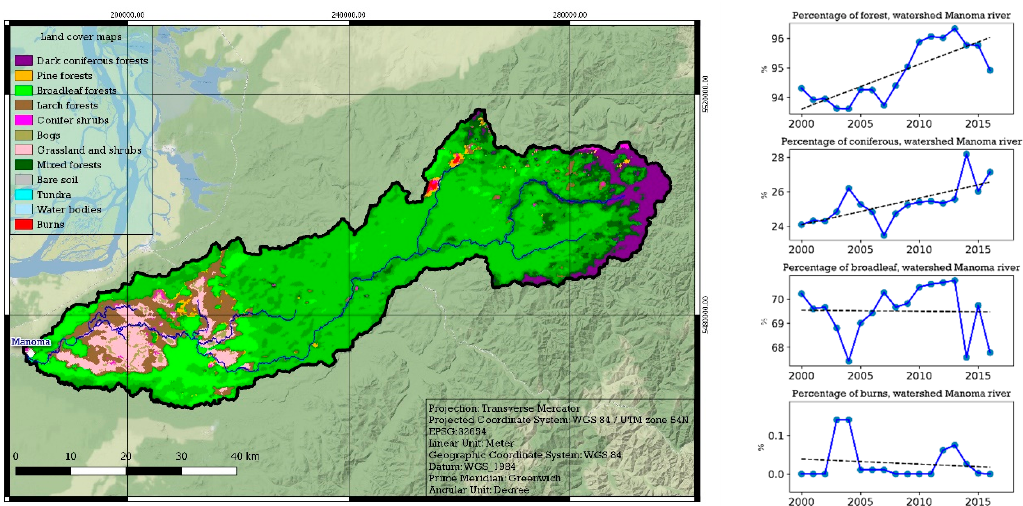
Figure 15. Vegetation dynamics of Bidzhan River watershed. Stream gaging is marked with the white diamond.